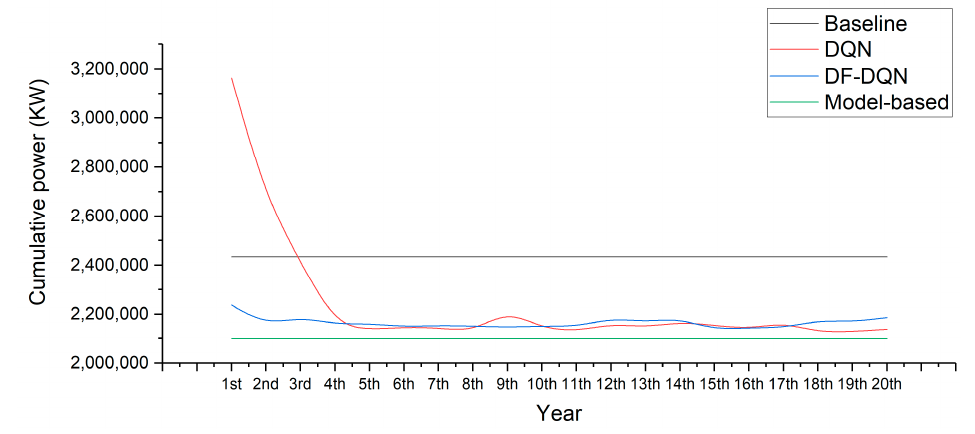
Figure 15. Cumulative power of each method in 20 years.